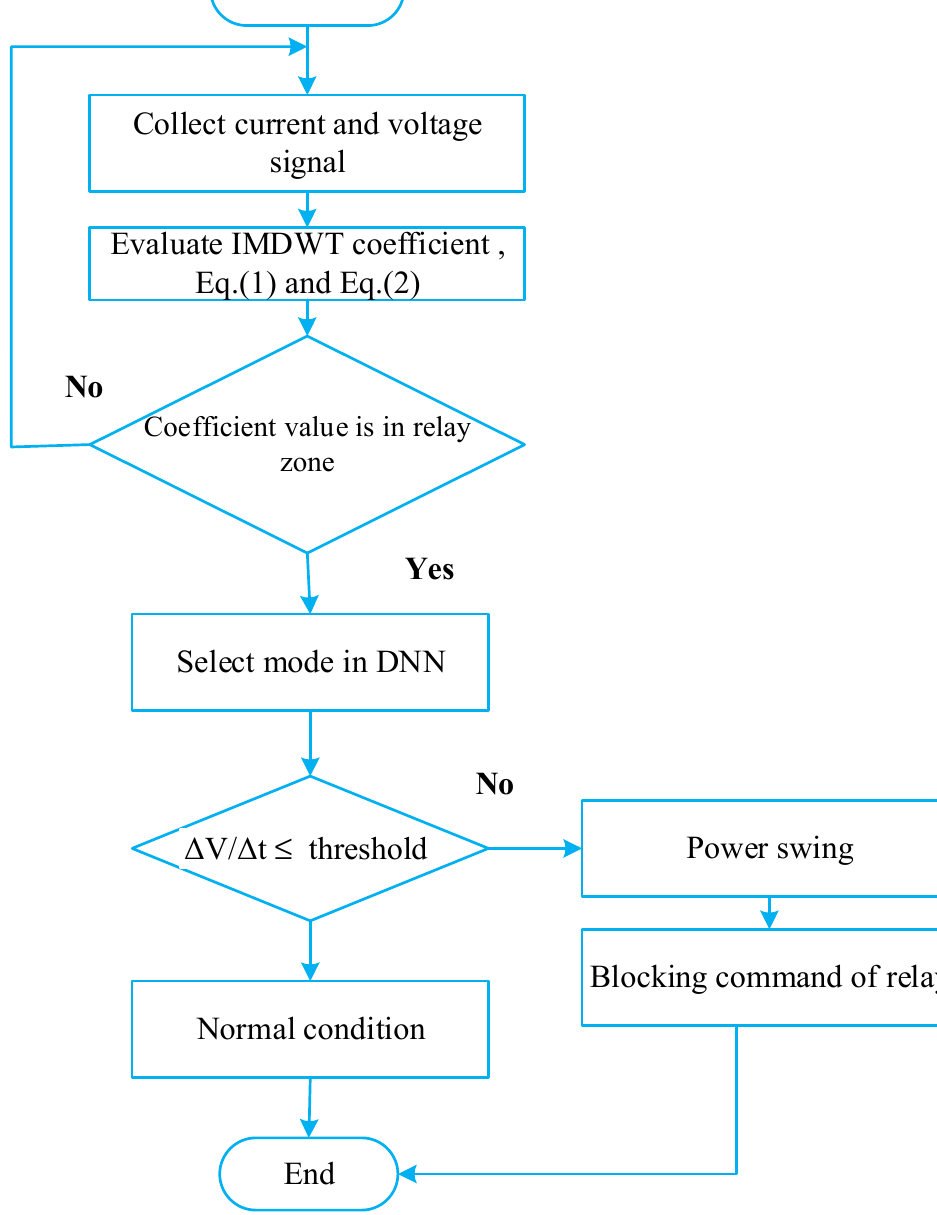
Figure 3. Flow chart of the proposed method. Algorithm 1: Pseudocode of Proposed Work